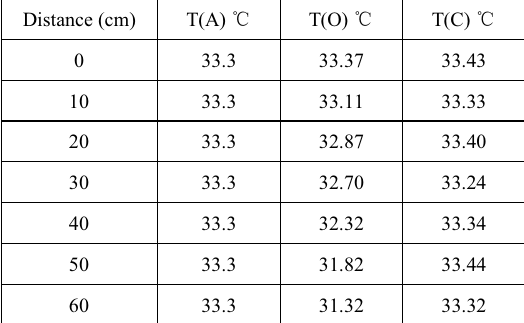
Table 1. Forehead temperature T(C) of subject